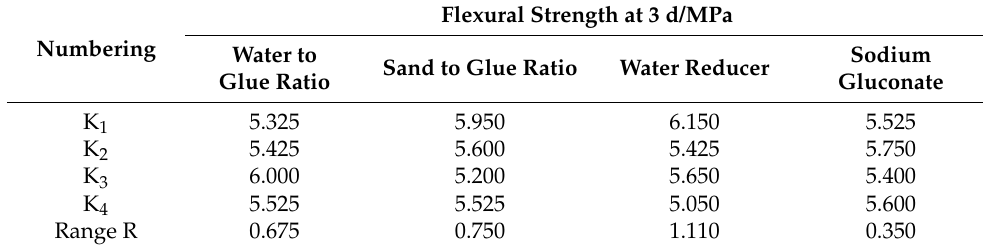
Table 12. Influence of various factors on flexural strength after 3